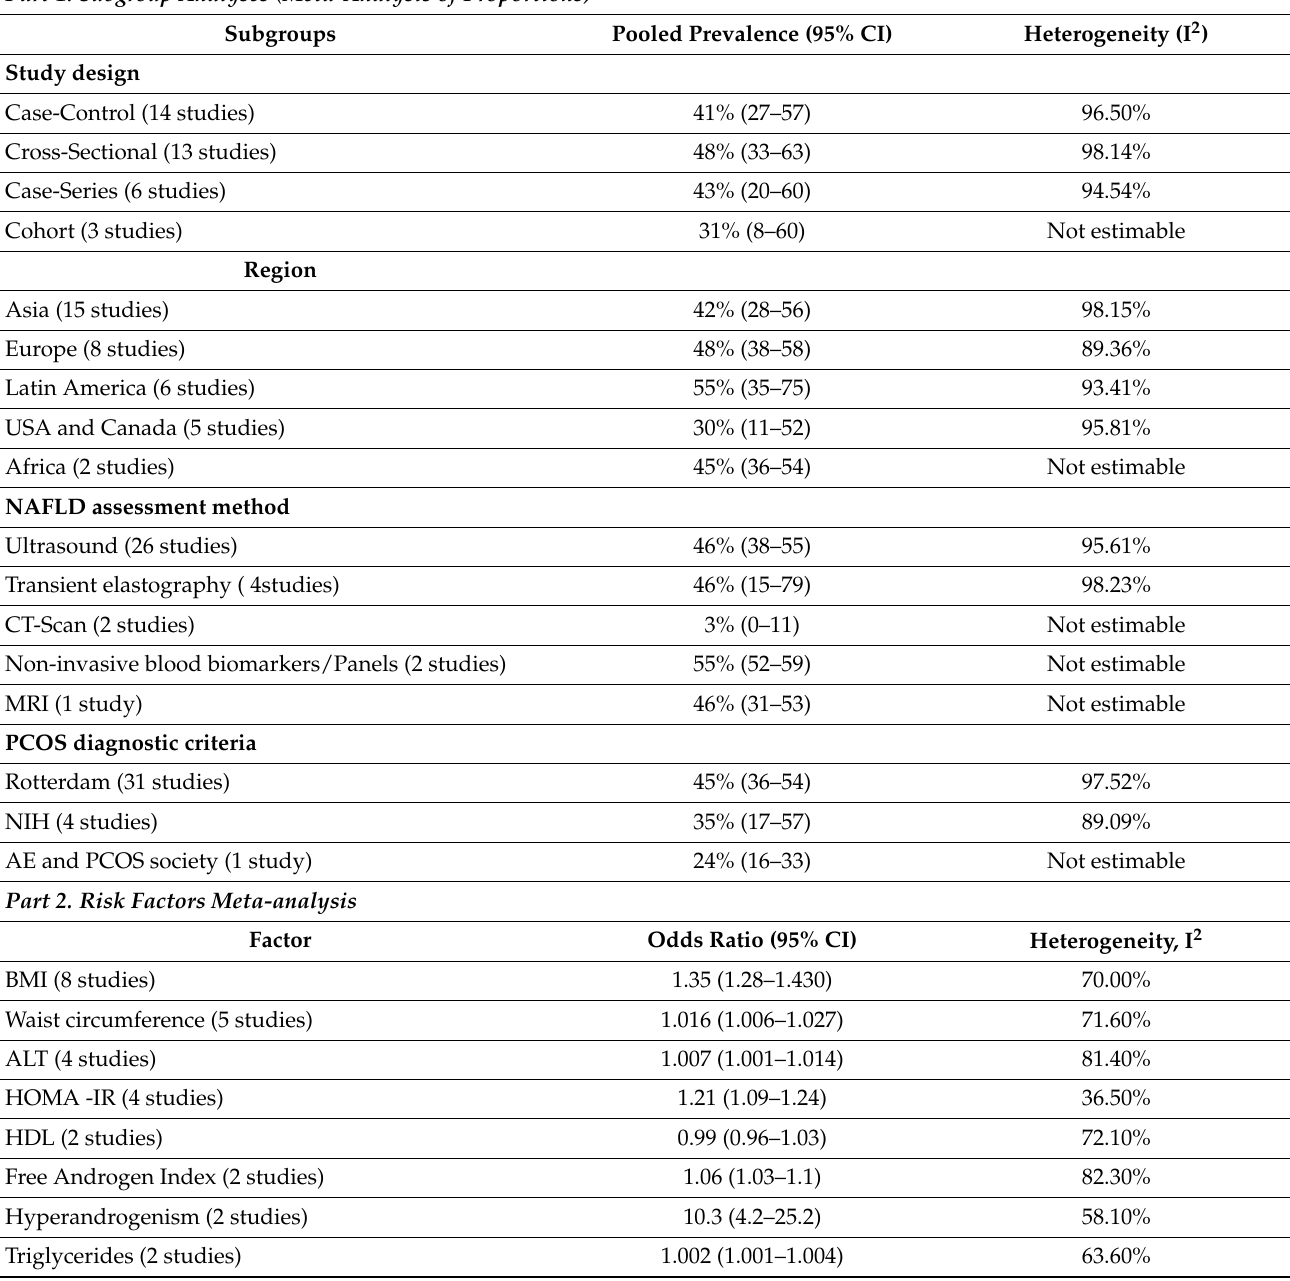
Table 2. Results from subgroups analyses (meta-analysis of proportions) and risk factors